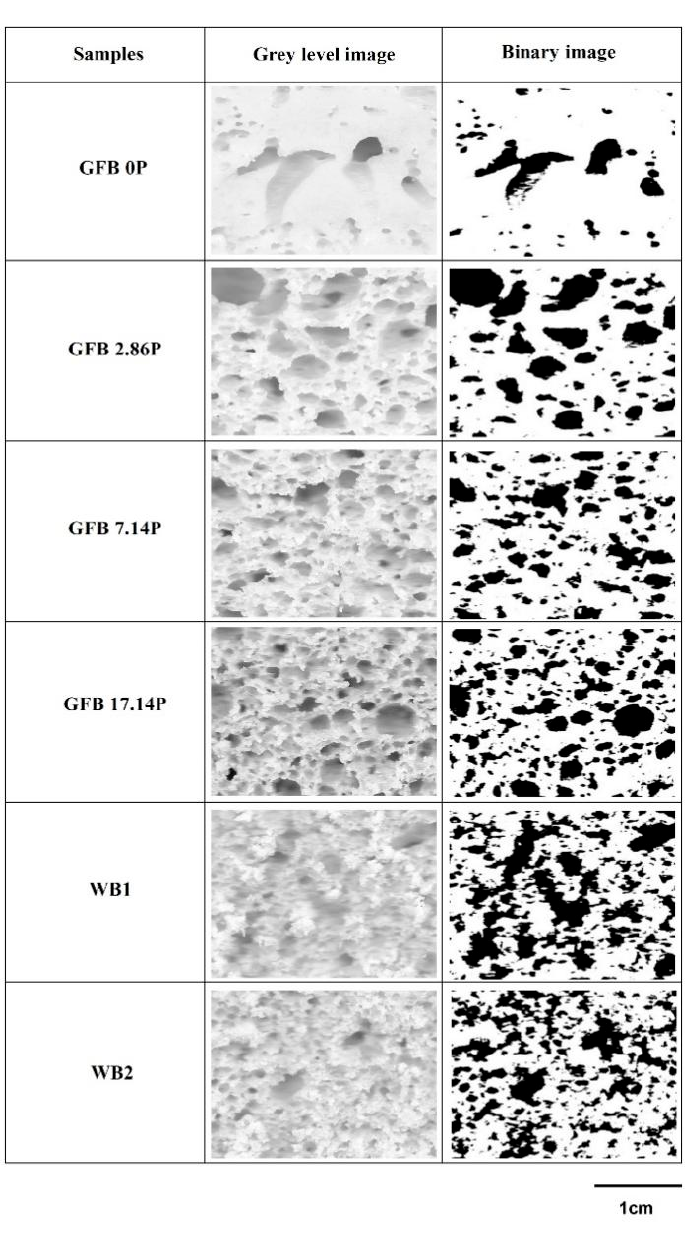
Figure 1. Crumb grain characteristics of gluten-free bread (GFB) formulations containing different psyllium levels (GFB0P, GFB2.86P, GFB7.14P and GFB17.14P) and the wheat counterparts (WB1 and WB2).